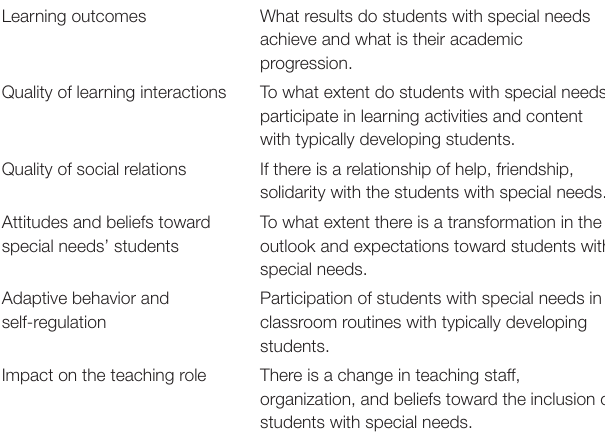
TABLE 3 | Description of analysis